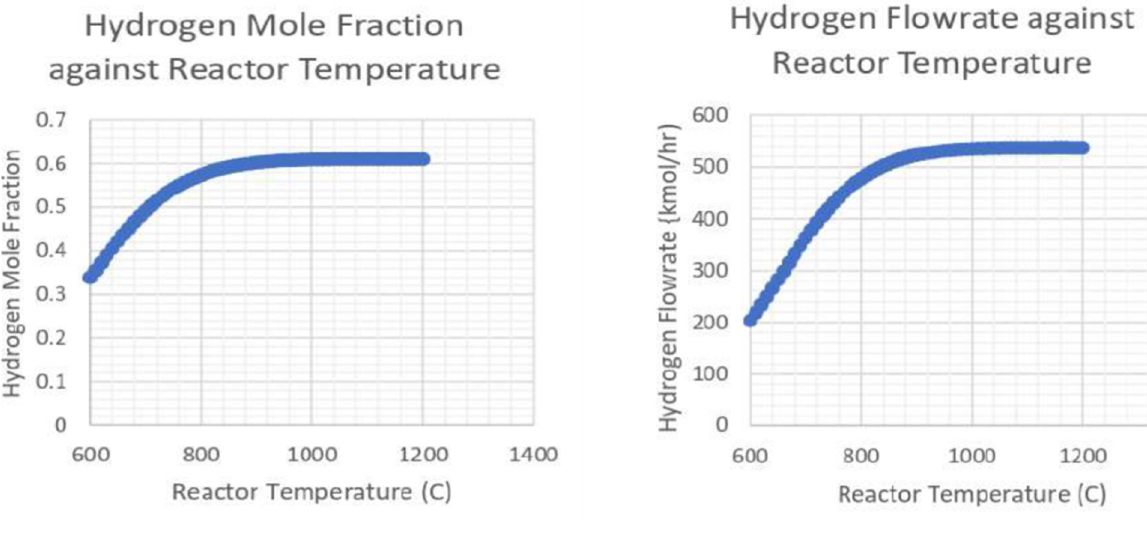
Figure 5. Sensitivity Analysis of Steam Reforming block B22.